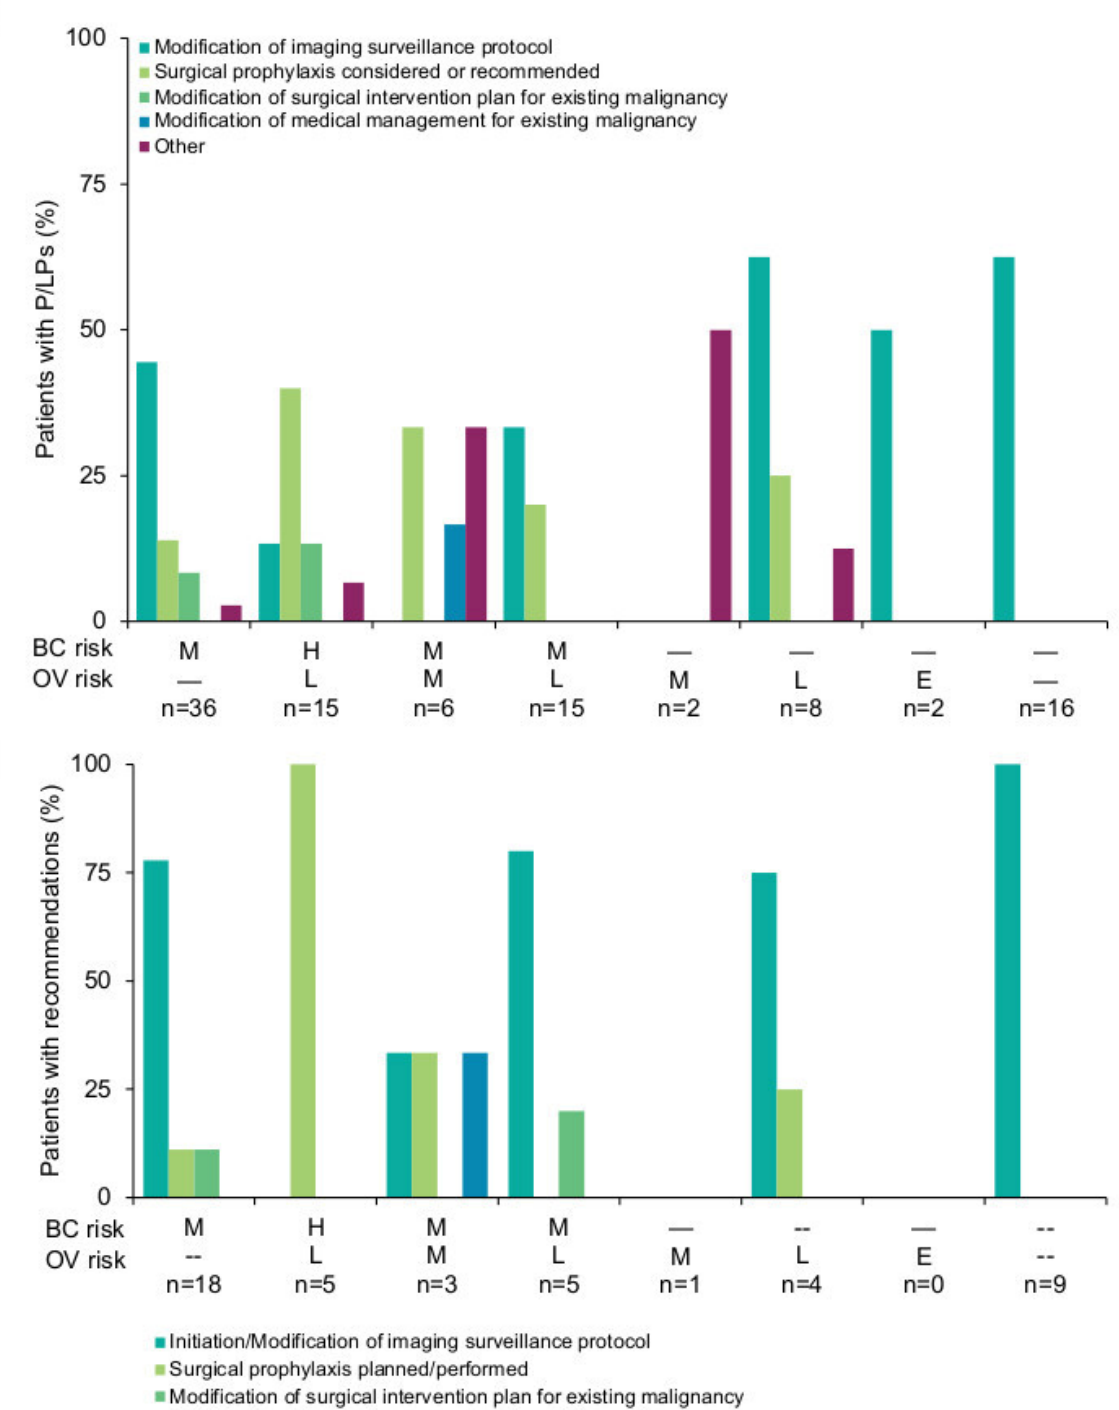
Figure 2. Clinical recommendations made to patients ( a ) and subsequent adherence ( b ). The percent of patients who received each recommendation was reported. The number of patients who received recommendations (numerator) versus the number of patients with a P/LP variant in each gene risk group (denominator) is reported in the x -axis. Modification of the medical management plan for existing malignancy included radiation therapy, chemotherapy, or other medications. Recommen- dations were made to patients with variants in the following genes: moderate breast cancer risk only ( CDH1 , CHEK2 , NF1 , and TP53 ); high breast cancer risk, minimally increased ovarian cancer risk ( PALB2 ); moderate breast and ovarian cancer risks ( RAD51C ); moderate breast cancer risk, minimally increased ovarian cancer risk ( ATM ); moderate ovarian cancer risk only ( MSH2 ); minimally